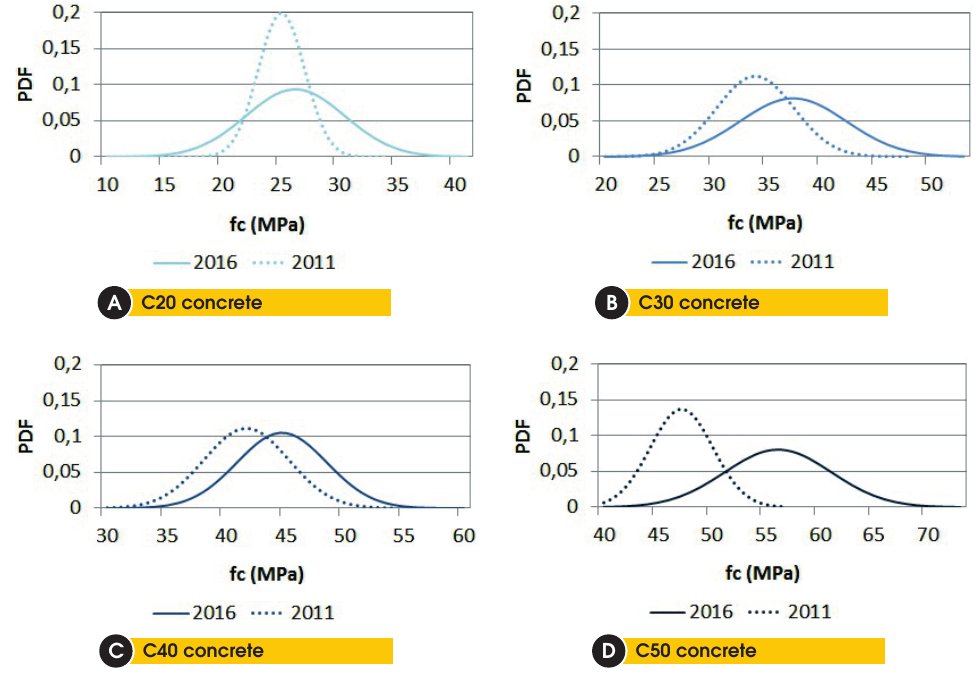
Comparison between the distribution functions of the concrete produced in Brazil until 2011 and